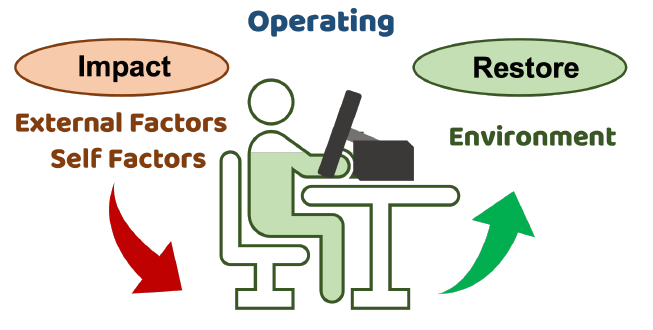
Figure 2. Architecture of driver